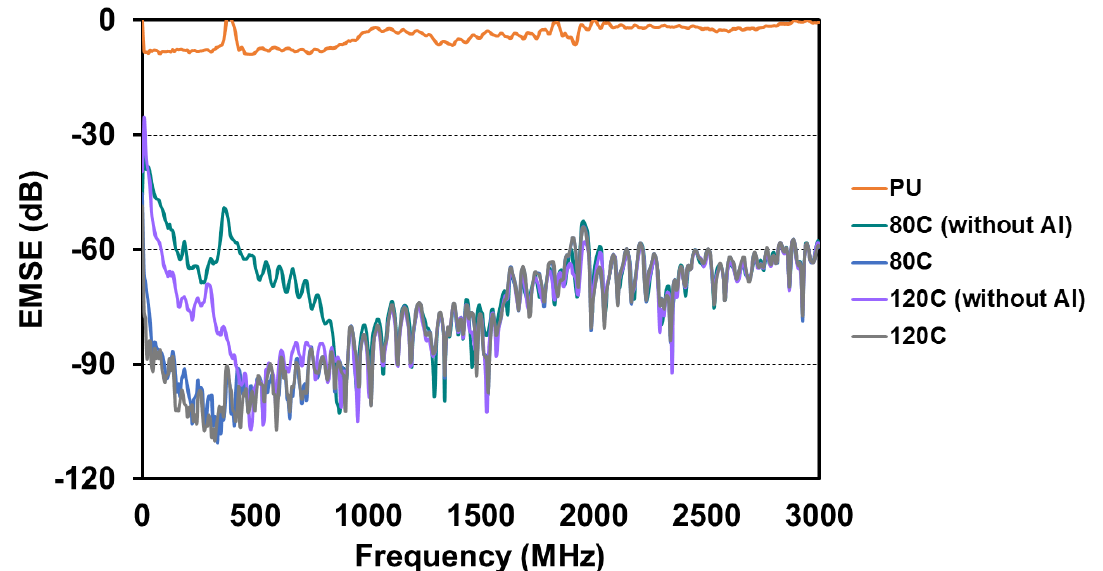
Figure 7. EMSE of PU foam composites.